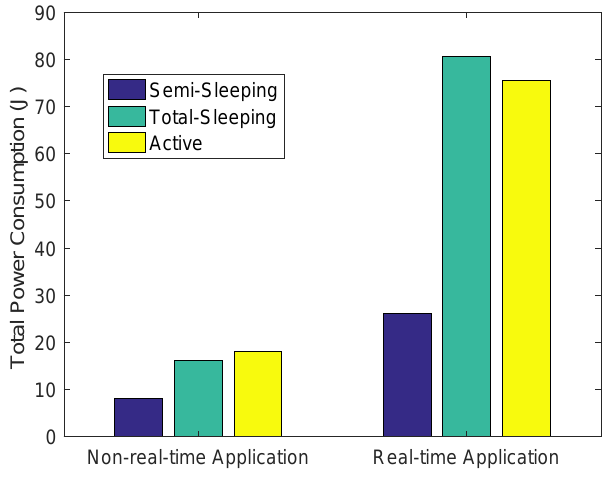
Figure 5. The total power consumption under different scheduling